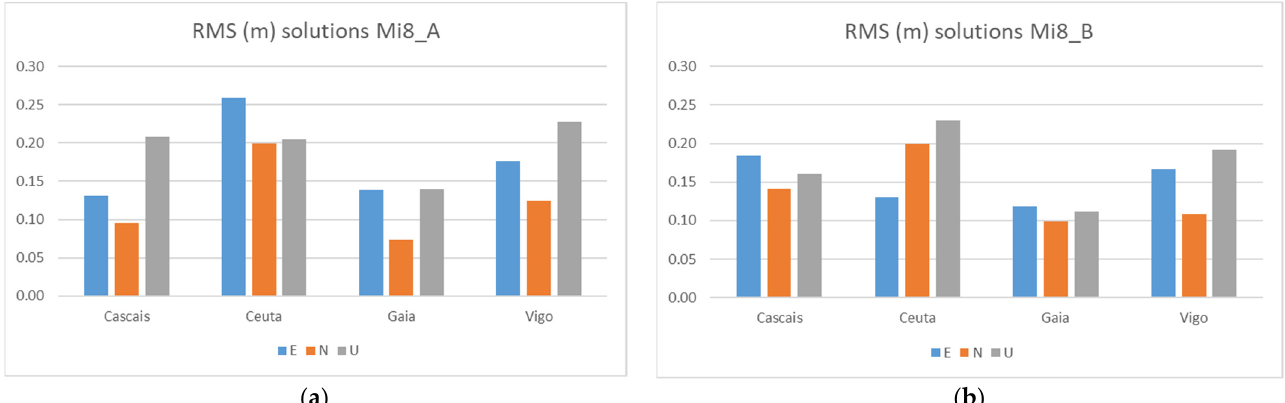
Figure 12. RMS Galileo + GPS solutions from the two Mi8 at Test 1: Mi_A ( a ) and Mi8_B ( b ).